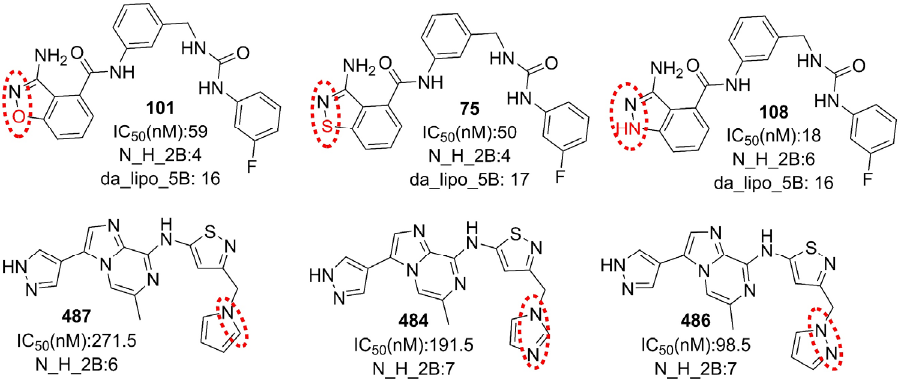
Figure 6. Representative examples to understand N_H_2B.